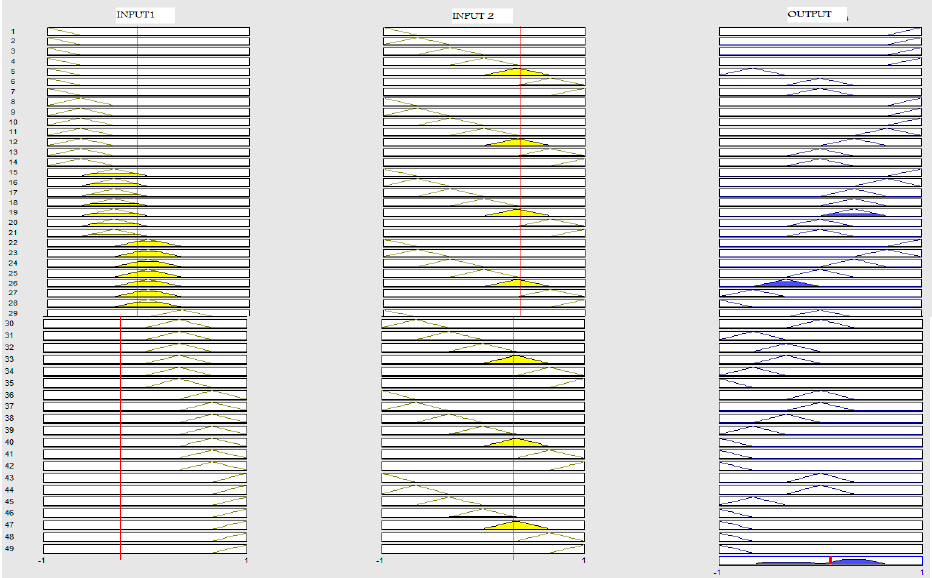
Figure 11. Fuzzy rules using the 7membership functions for fuzzy controller. The surface viewer for the seven membership function rules on MATLAB is shown in Figure 12.